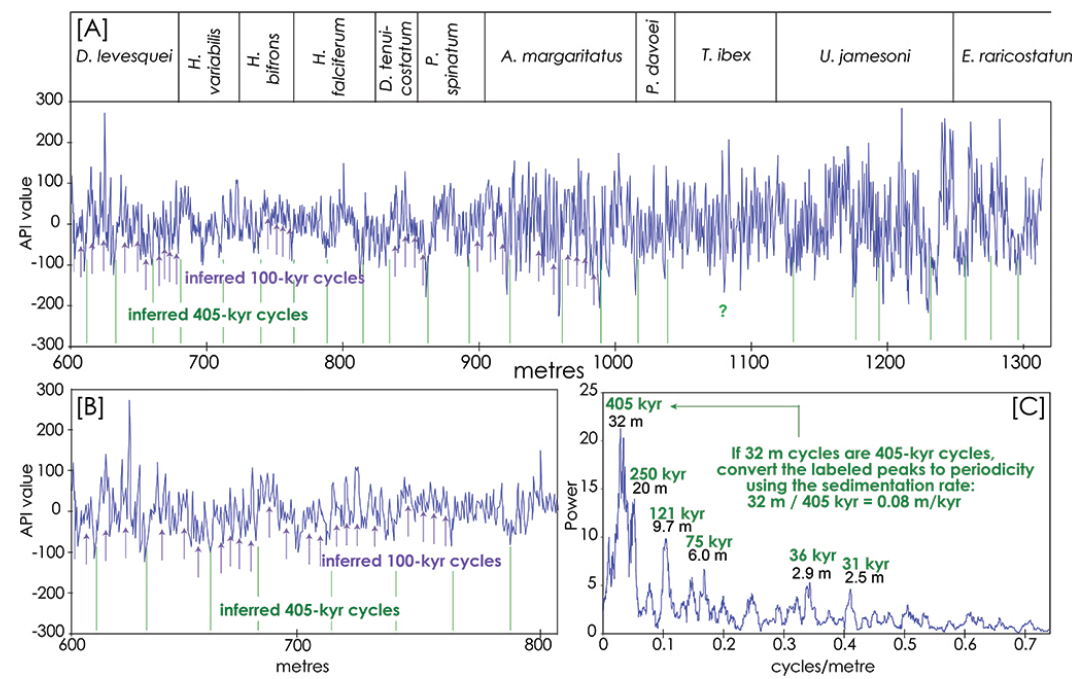
Figure 7. Gamma ray log from the original Mochras borehole, digitized from original analog graphs. (a) Entire series after removing a long- term irregular trend. (b) Interval from the upper part of the borehole highlighting ∼ 32m cycling interpreted as 405kyr cycles, (green) and 6–9.7m cycles interpreted as ∼ 100kyr cycles (purple). (c) Multitaper power spectrum of the entire gamma-ray log series and preliminary Milankovitch